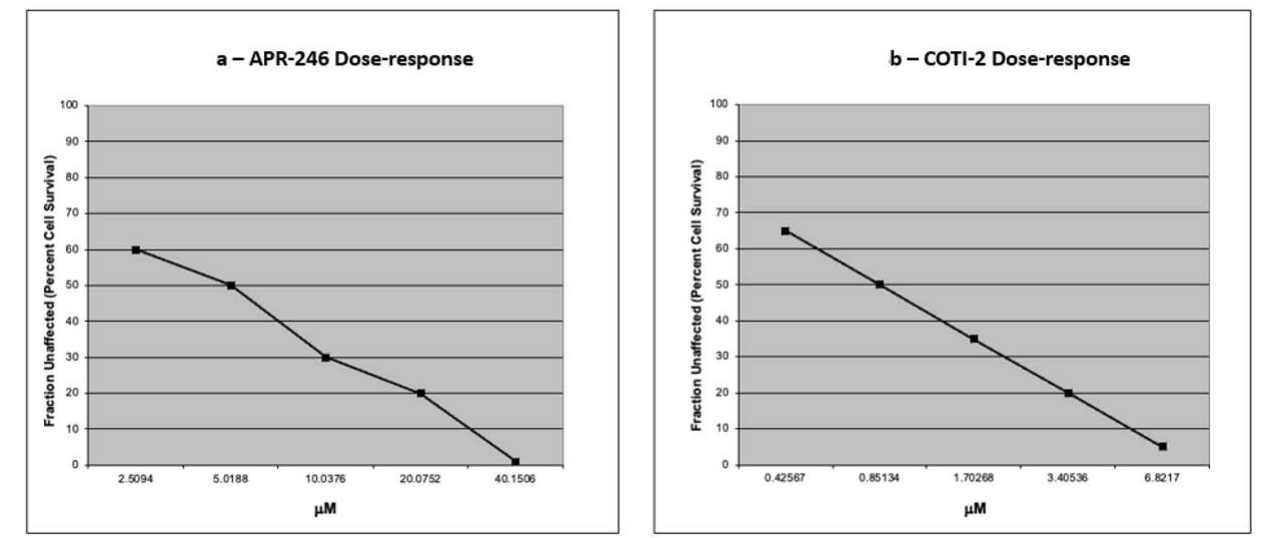
Figure 4. ( a , b )—provide representative dose–response curves for APR-246 and COTI-2. Following 72 h drug exposure, tumor cell percent viability (0–100) measured against saline controls are provided in 5-point serial dilutions. Drug concentrations are provided as mMolar. Lethal concentration 50% (LC50) are interpolated using best line fit analyses.